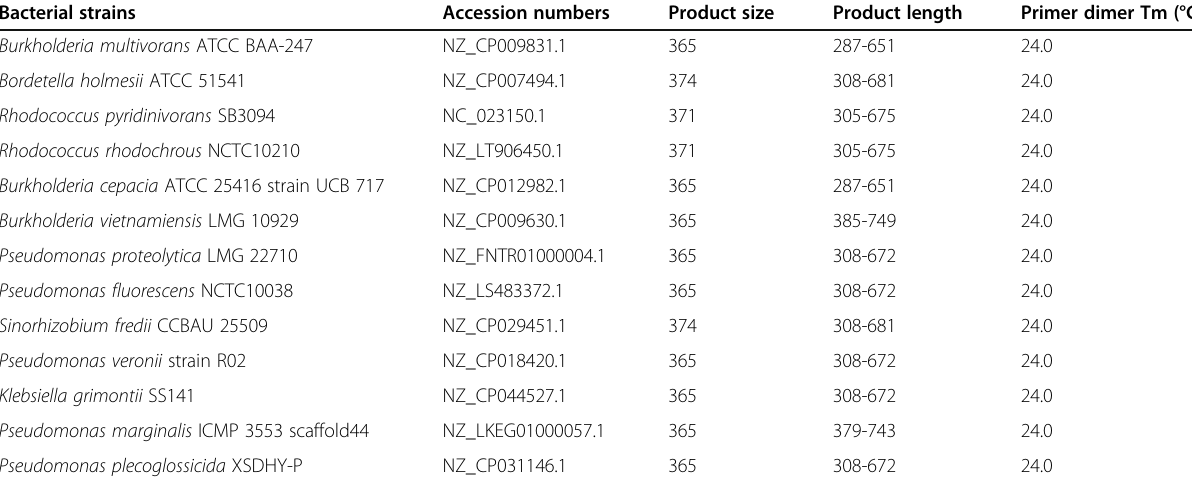
Table 10 In silico PCR analysis of primer pair catAf/catAr with targeted sequences Bacterial strains